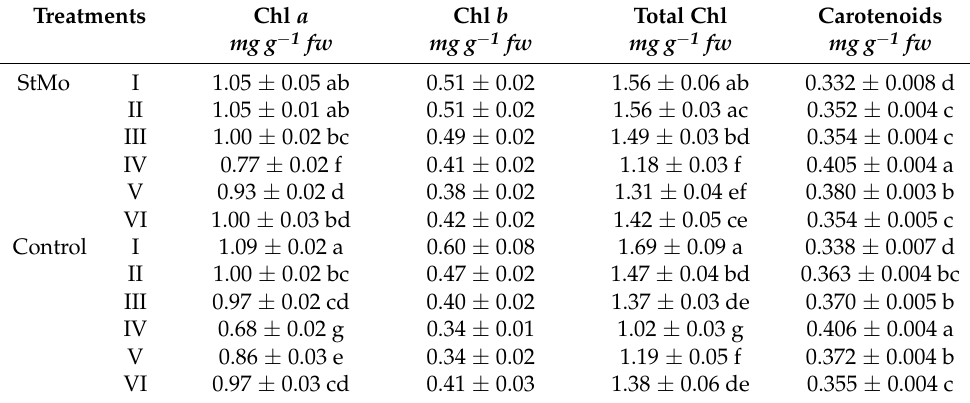
Table 11. Interaction biostimulant × harvest (B × H) on the average content of chlorophyll a (Chl a ), chlorophyll b (Chl b ), total chlorophyll and carotenoids average in rocket. Different letters within each column indicate significant differences at p = 0.05 (Tukey’s